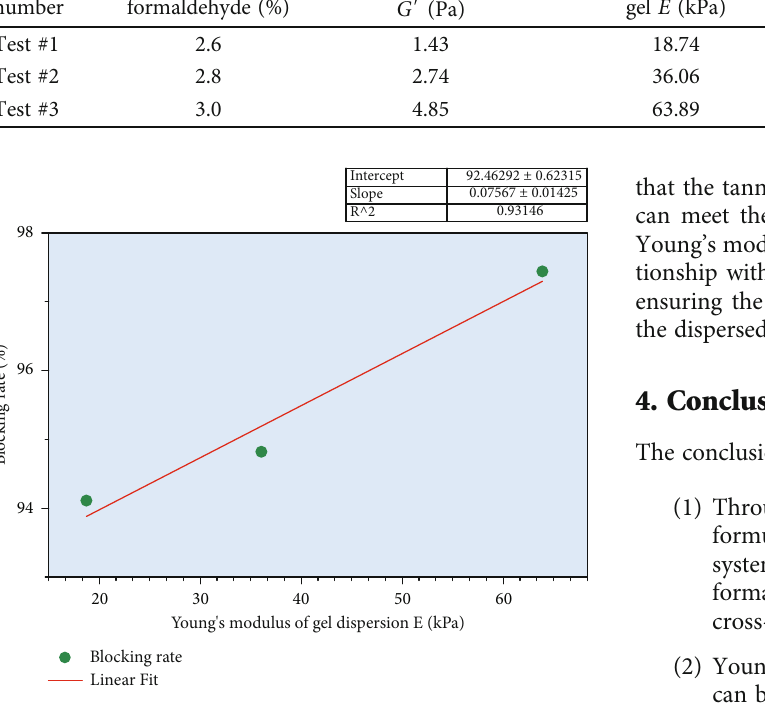
Figure 22: The plugging rate of dispersed gel varies with Young ’ s